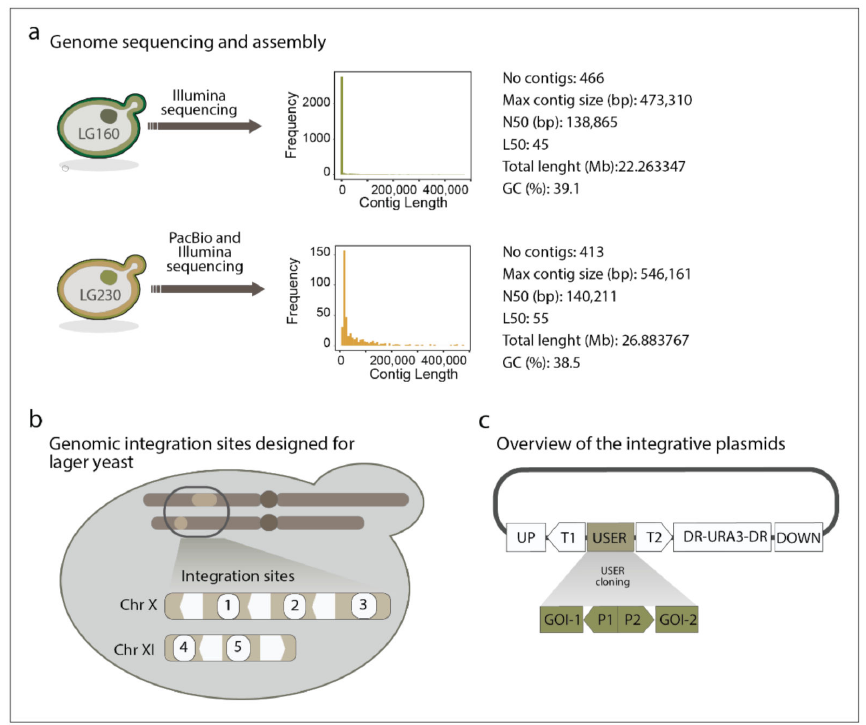
Figure 1. Overview of the genome sequencing, assembly, and design of a gene integration toolbox for S. pastorianus yeast. ( a ) The genomic DNA of the lager yeast LG160 and LG230 was sequenced using two different approaches. The genome of LG160 was solely sequenced by Illumina HiSeq sequencing platform and the genome of LG230 was sequenced using a mix of sequencing technologies: Illumina HiSeq and PacBio. The Quality of the final genome assembly was assessed by QUAST [52] software. The statistics of the assembly are presented as number of contigs (No contigs), maximum contig size, N50, L50, GC content, and the total length. ( b ) Five integration sites were design based on the gene integration toolbox presented in [54]. The integration sites, numbered boxes, are organized in clusters in two chromosomes which are homologous to S. eubayanus chromosomes X (Chr X) and S. cerevisiae chromosomes XI (Chr XI). ( c ) Overview of the integrative plasmid suitable S. pastorianus lager strains auxotrophic for uracil. The cassette containing a single or a double bidirectional promotor (P1-P2) and up to two genes of interests (GOI) can be assembled by USER TM cloning into the parental vectors. The recombination sites in the parental vectors, UP and DOWN, are unique for each integration